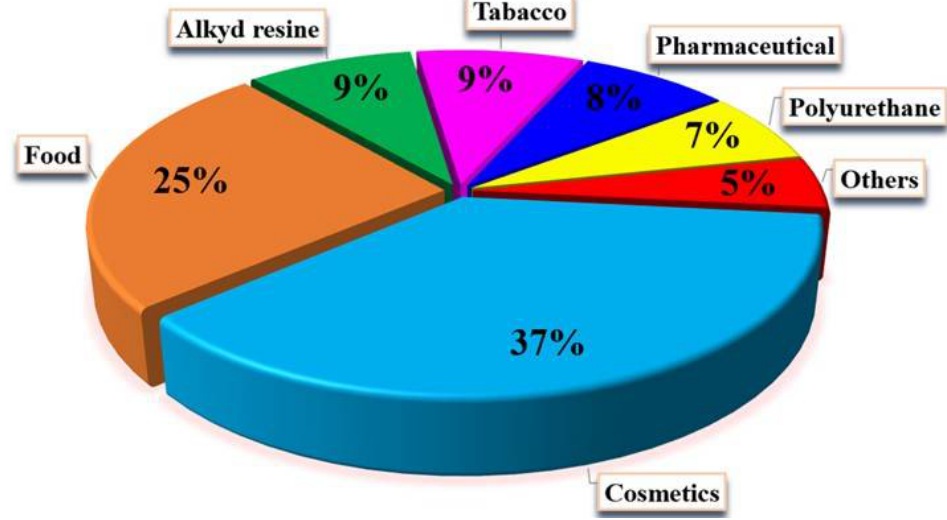
Figure 2. Percentage of glycerol application in different fields. Data collected from [34], open access journal of Membranes.